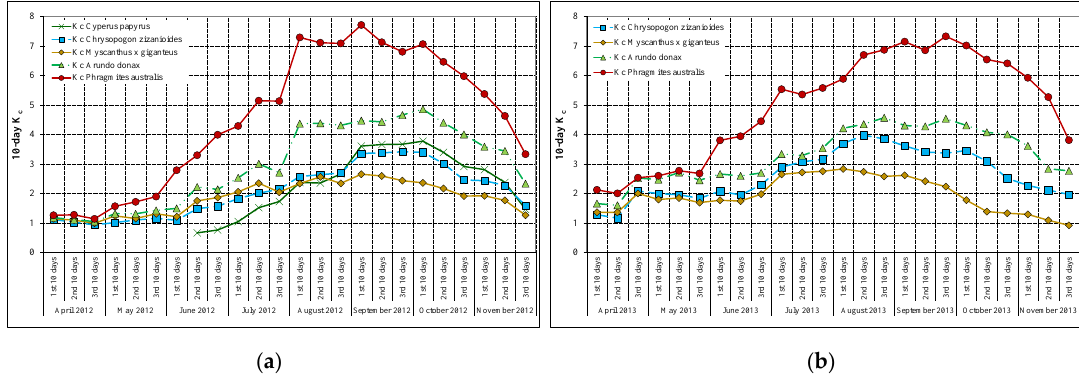
Figure 9. 10-day Kc of C. papyrus , C. zizanioides , M. giganteus , A. donax, and P. australis during 2012 ( a ) and 2013 ( b ) observation periods.